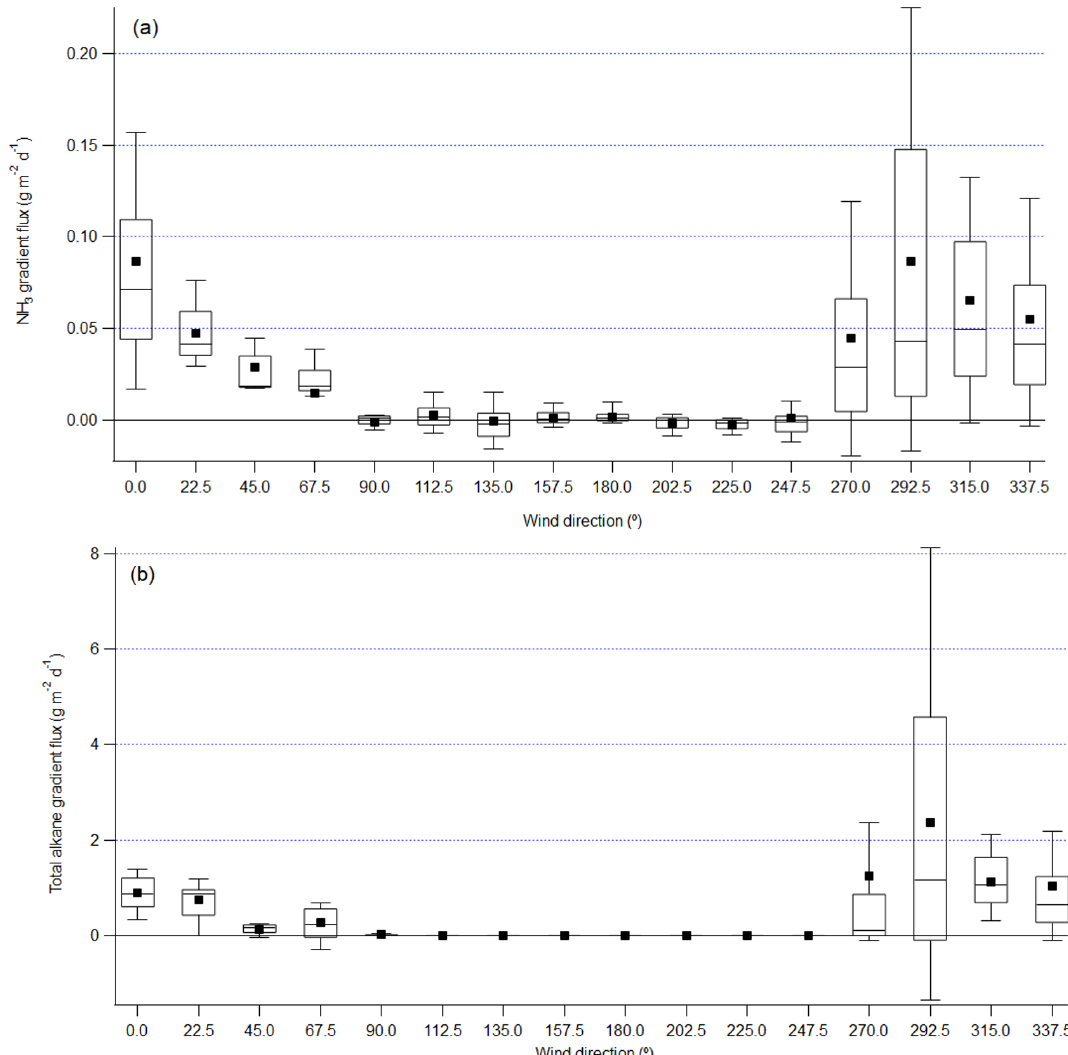
Figure 4. Gradient flux of NH 3 (a) and total alkane (b) from FTIR top-bottom path binned by wind direction in 22.5 ◦ bins. Lower and upper bounds of the box plot are the 25th and 75th percentile; the line in the box marks the median and the black square labels the mean; the whiskers label the 10th and 90th